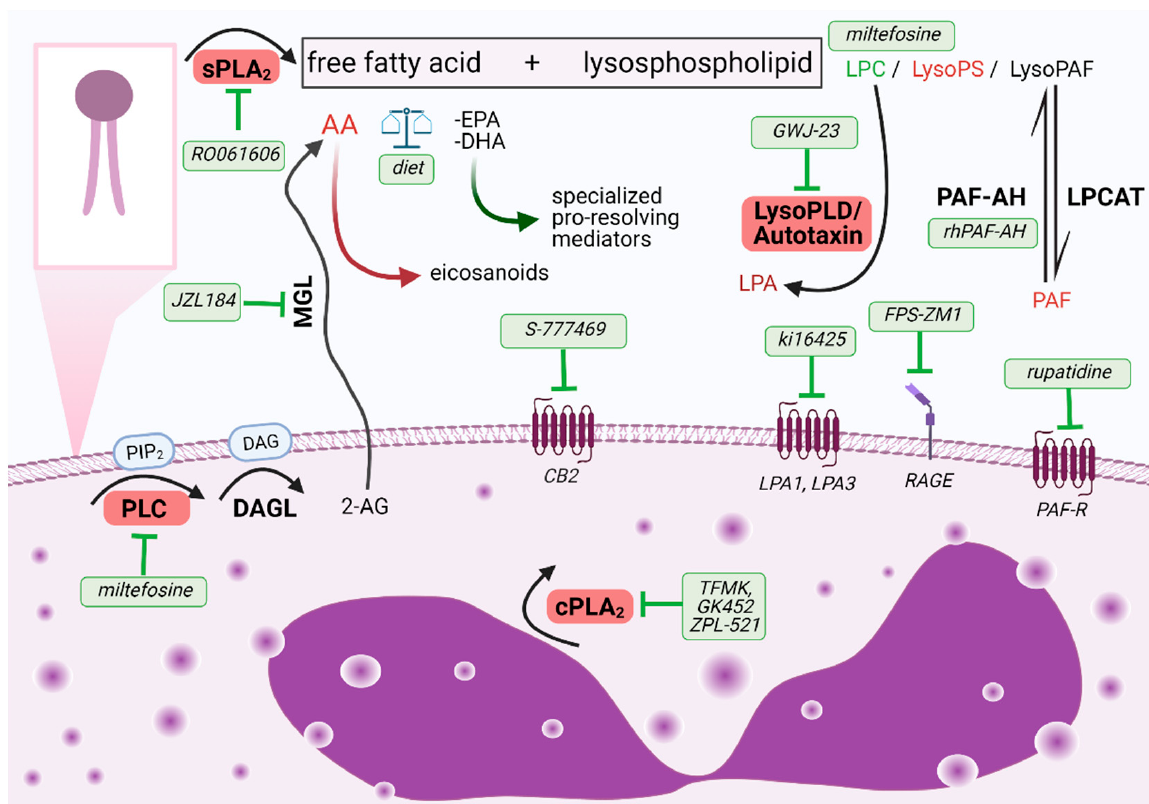
Figure 1. Overview of the phospholipid cleavage by phospholipases and major bioactive mediators produced during this process. Identified potential inhibitors of (i) enzyme activities or (ii) receptor antagonists targeting eosinophil over-activation are highlighted in green. Abbreviations: 2-AG, 2-arachidonoylglycerol; AA, arachidonic acid; CB2, cannabinoid receptor type 2, cPLA 2 , cytosolic phospholipase A2; DAG, diacylglycerol; DAGL, diacylglycerol lipase; DHA, docosahexaenoic acid; EPA, eicosapentaenoic acid; LPA, lysophosphatidic acid; LPA1,3, lysophosphatidic acid receptors type 1 and 3; LPC, lysophosphatidylcholine; LPCAT, lysophosphatidylcholine acyltransferase; LysoPAF, lyso platelet-activating factor; LysoPLD, lysophophospholipase D; LysoPS, lysophosphatidylserine; MGL, monoacylglycerol lipase; PAF, platelet-activating factor; PAF-AH, platelet-activating factor acetylhydrolase; PAF-R, platelet-activating factor receptor; PIP2, phosphatidylinositol 4,5-bisphosphate; PLC, phospholipase C; RAGE, receptor for advanced glycation end products; sPLA 2 , secreted phospholipase A2.